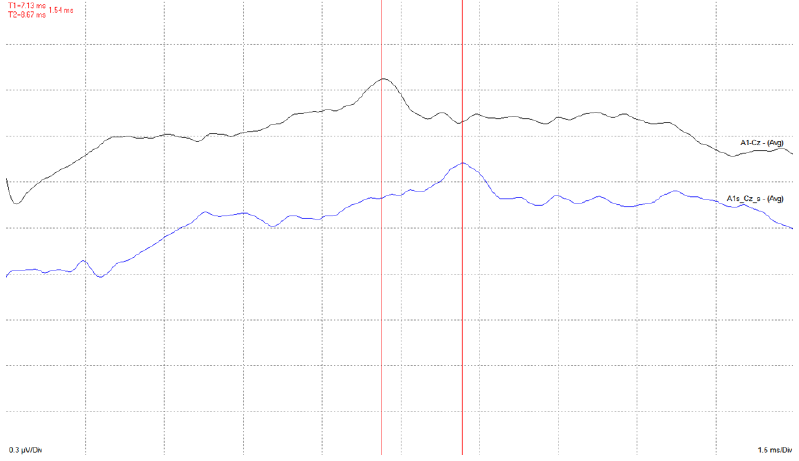
Figure 17. AEP of a healthy volunteer. Grey curve, originally obtained from the system. Blue curve, obtained from the proposed system. Voltage scale is 0.3µV/div, time scale is